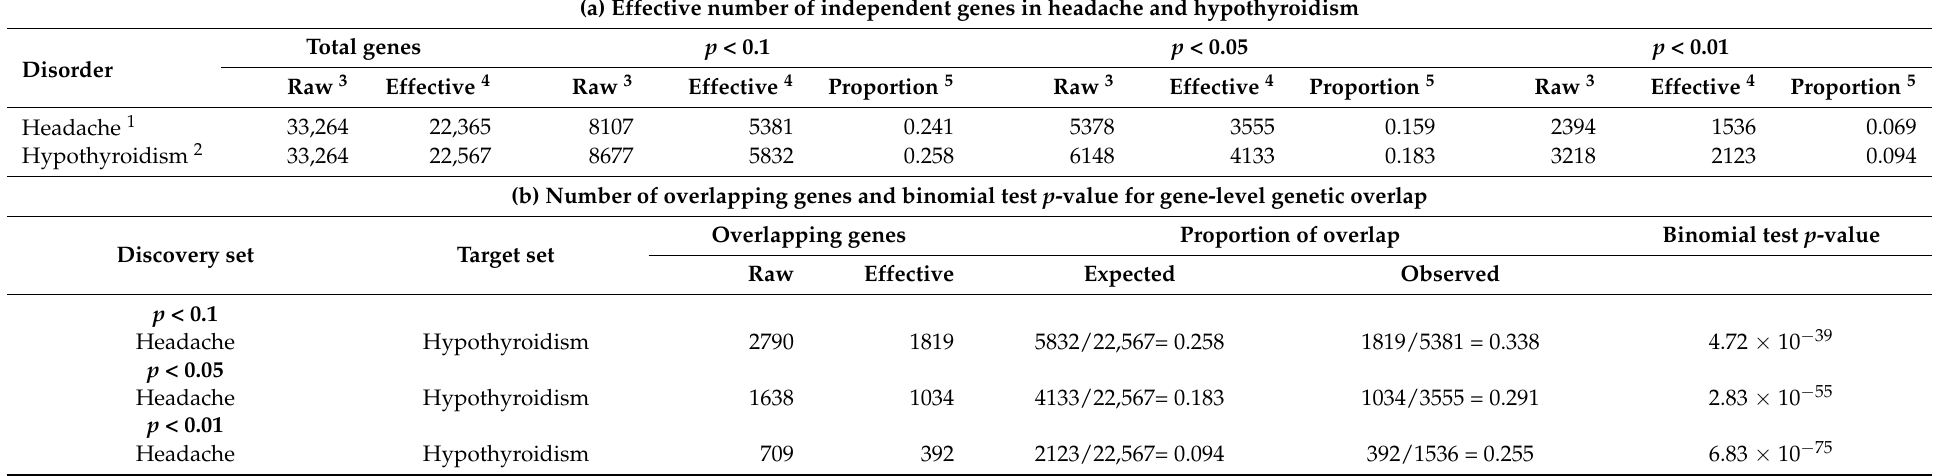
Table 4. Independent gene-based association analysis and gene-based genetic overlap between headache and hypothyroidism. (a) Effective number of independent genes in headache and hypothyroidism Total genes p < 0.1 p < 0.05 p < 0.01